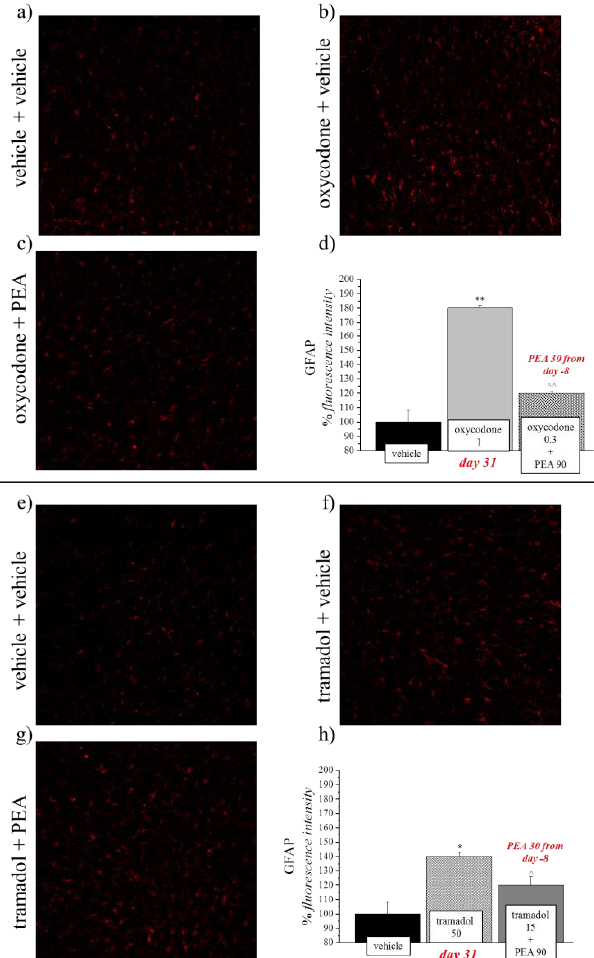
Figure 8. Effect of different combinations of opioids and PEA on the astrocytic profile in the lumbar spinal cord. Rats were treated with the vehicle or pre-emptive PEA (30 mg kg − 1 ) p.o. daily (in the evening) for the duration of the experiment, starting on Day − 8. To maintain a significant increase in the pain threshold (90 ± 10 g) vs. baseline, beginning on Day 1, daily increasing doses of ( b ) oxycodone (0.3–1 mg kg − 1 ) or ( f ) tramadol (15–50 mg kg − 1 ) were injected s.c. Different combinations of ( c ) oxycodone (0.3 mg kg − 1 ) or ( g ) tramadol (15 mg kg − 1 ) and PEA (30–90 mg kg − 1 , p.o.) were administered to Groups c and f, respectively. Control animals ( a , e ) were treated with vehicles. On Day 31, the number of GFAP-positive cells was measured in the dorsal horn of the L4–L5 spinal cord. Transverse sections of the spinal cord imaged at × 20 objective (scale bar = 50 µ m. Histograms ( d , h ) show a quantitative analysis of the GFAP fluorescence intensity. Each value represents the mean ± S.E.M. of six rats, obtained by analysing four independent fields for both sides of the dorsal horn of the lumbar spinal cord. Statistical analysis was one-way ANOVA followed by Bonferroni’s post hoc comparison. * p < 0.05 and ** p < 0.01 vs. vehicle + vehicle group; ˆ p < 0.05 and ˆˆ p < 0.01 vs. oxycodone or tramadol + vehicle treated